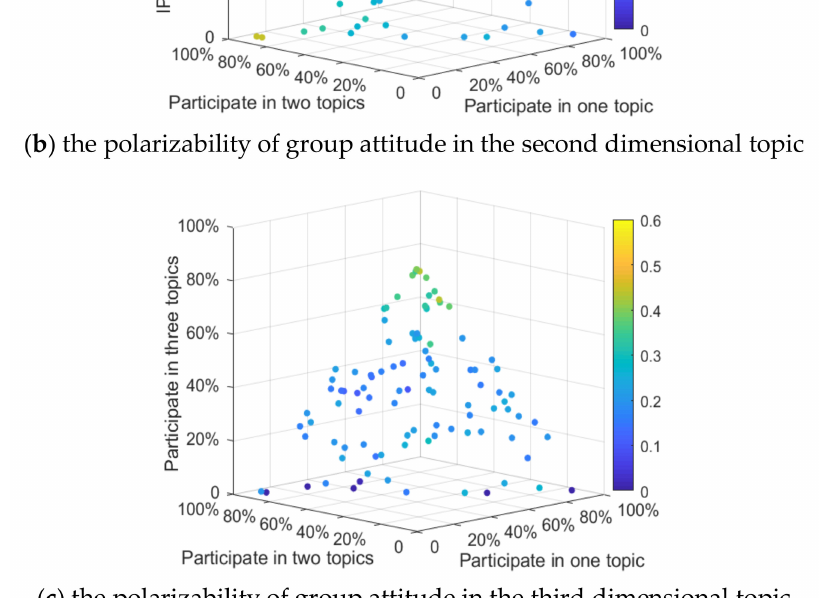
Figure 5. The polarizability of group attitude when individuals randomly engage in several